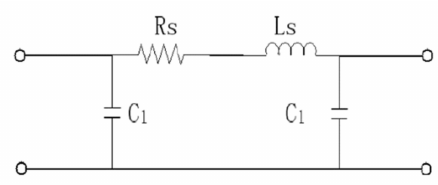
Figure 10. Gold wires lumped-parameter